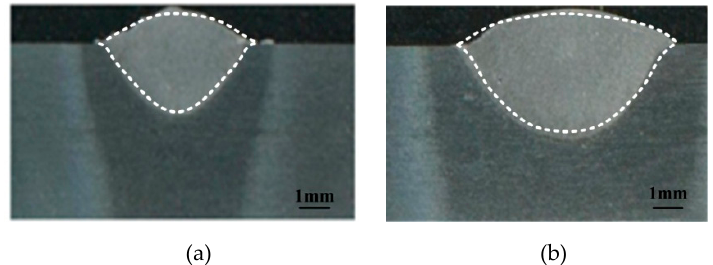
Figure 14. Experimental result of fluid flow for hybrid welding of aluminum alloy [8].